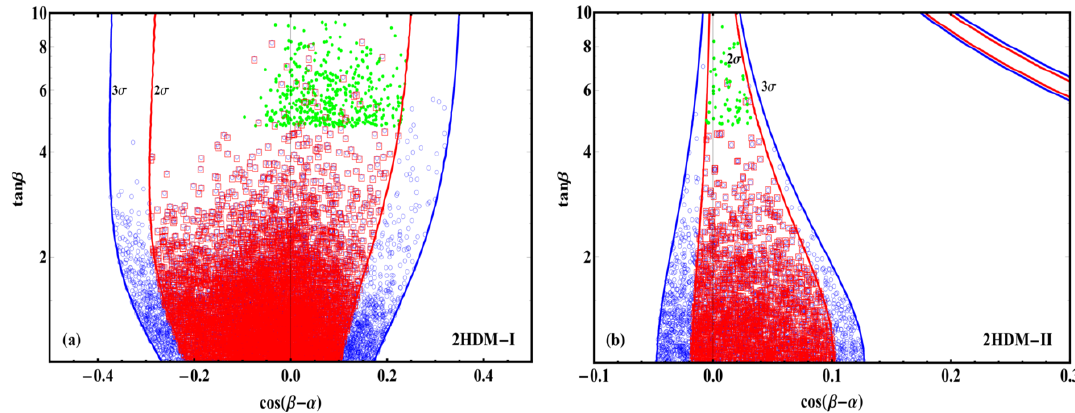
Figure 2 . Constraints on the 2HDM parameter space by the global (cid:12)t of the light Higgs boson h (125GeV). Plot-(a) shows the limits for 2HDM-I and plot-(b) for 2HDM-II, where the red (blue) curves give the 2 (cid:27) (3 (cid:27) ) contours (without theory and precision constraints). The region with red (blue) dots depict the allowed parameter space by including both the theory constraints and the Higgs global (cid:12)t at 2 (cid:27) (3 (cid:27) ) level. The dotted regions present a uniform parameter scan which favors relatively low tan (cid:12) . The green dots are generated at 2 (cid:27) level for the special parameter region obeying M 2 = M 2 cos 2 (cid:11) cot (cid:12) and tan (cid:12) > 12 H